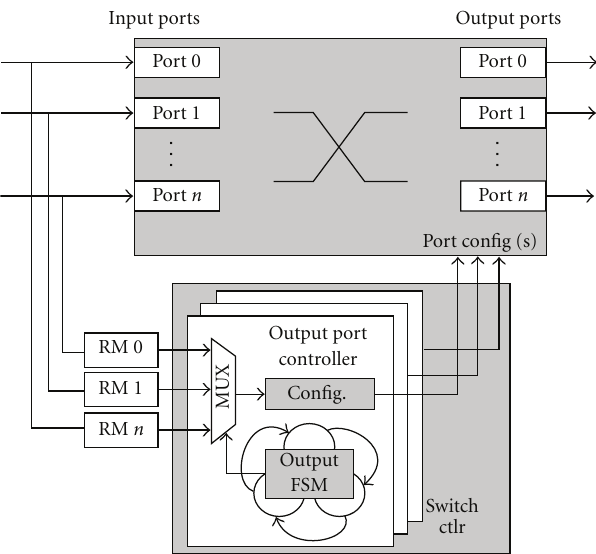
Figure 2: Block diagram of the AIREN